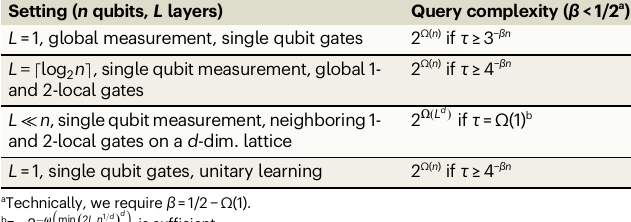
Table 2 | Relatively simple classes of functions require exponentially many statistical queries to learn using any naive algorithm that reduces to statistical queries Setting ( n qubits, L